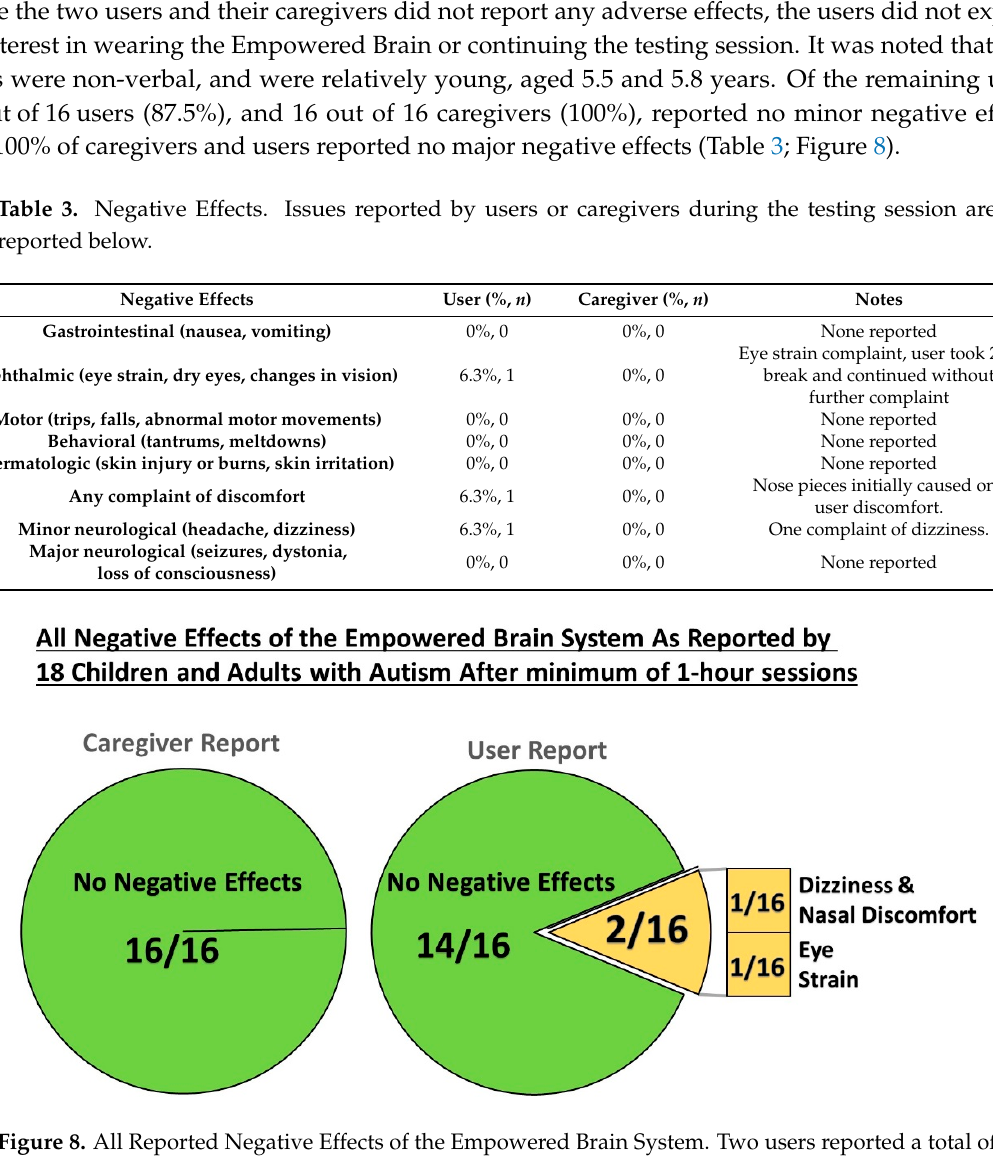
Table 3. Negative Effects. Issues reported by users or caregivers during the testing session are reported below.